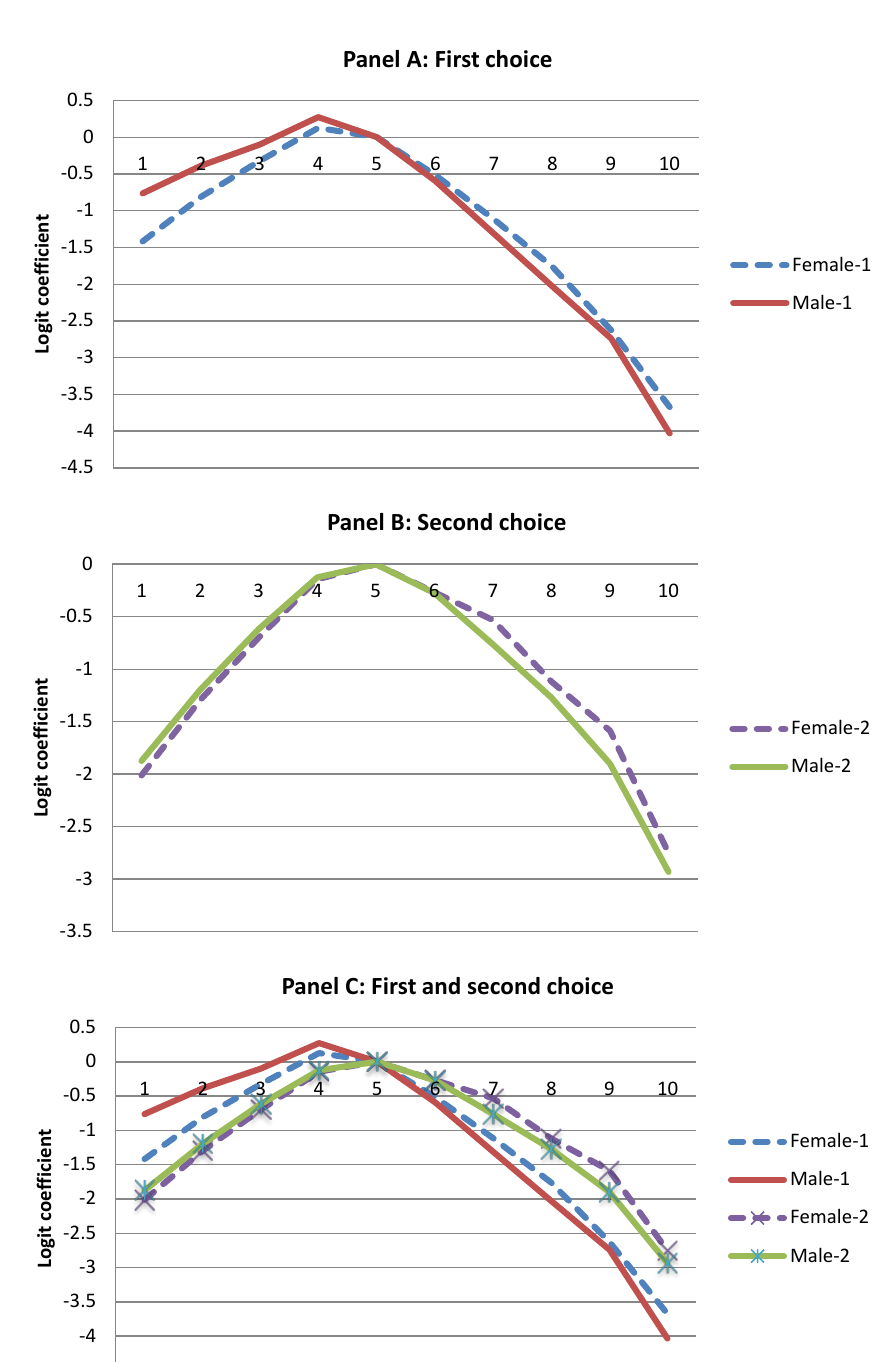
Figure 5: Multinomial Preferences Model: Effects of Difficulty of Being Accepted on First-choice and Second- choice TECH. Based on the results of Tables 4A and 4B (A) First choice, controlling for major dummy variables. (B) Second choice, controlling for major dummy variables. (C) First and second choices, controlling for major dummy